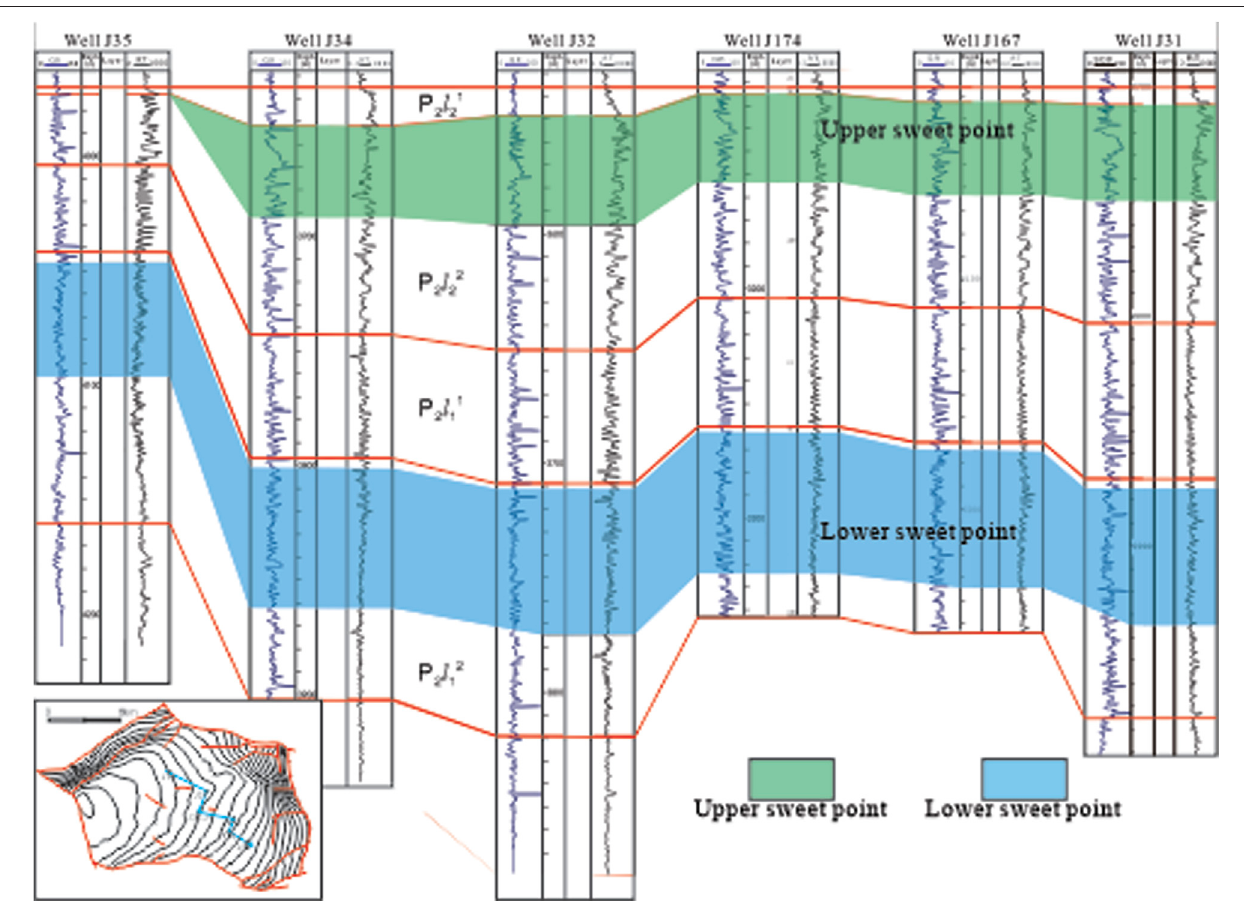
Frontiers in Earth Science |